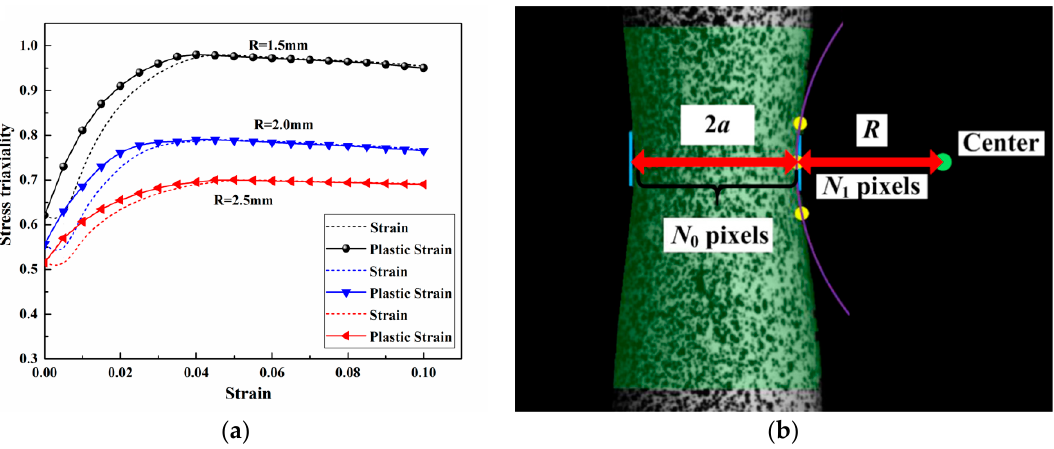
Figure 3. ( a ) Relationships between the stress triaxiality and the strain for the specimens with three kinds of notches; and ( b ) schematic diagram for the revised strain triaxiality of the smooth quasi-static tensile specimens.